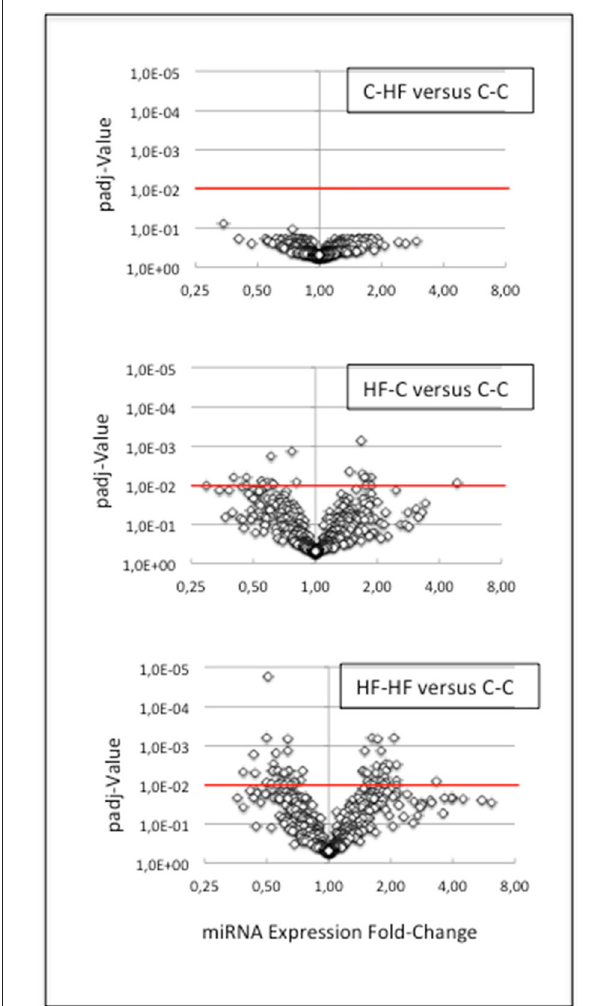
FIGURE 6 | miRNA response to metabolic challenge. We compared miRNA expressions between groups C-C and C-HF, HF-C, or HF-HF. For each comparison, the volcano plot displays padj-values plotted against expression fold-changes. X- and Y-axes are drawn using log 2 and log 10 scales, respectively. Values higher than 1 on the X-axis denote up-regulated miRNAs in groups C-HF, HF-C, or HF-HF, and values lower than 1, down-regulated miRNAs. Red lines identify the threshold padj-value of 1.0E-2. (Upper Plot) C-HF vs. C-C comparison. All padj-values were higher than 7.0E-2. miRNAs did not display any expression difference. (Middle Plot) HF-C vs. C-C comparison. Eighteen miRNAs displayed significant difference of expression. (Lower Plot) HF-HF vs. C-C comparison. Sixty miRNAs displayed significant difference of expression. The expression of several miRNAs was impacted by the perinatal only, or perinatal and adult, unbalanced environment.